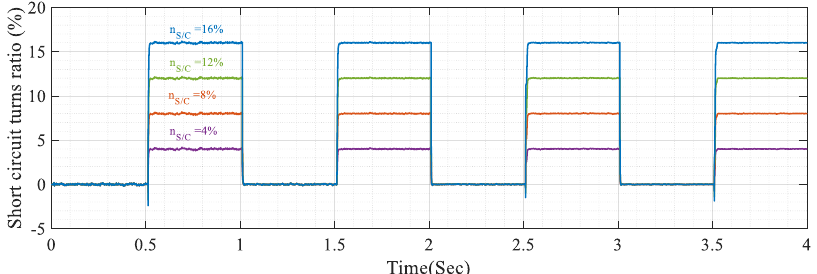
Figure 17. Estimation response in phase A at a load of 0.75 A with frequency variation from 20 to 50 Hz and 10 Hz step.